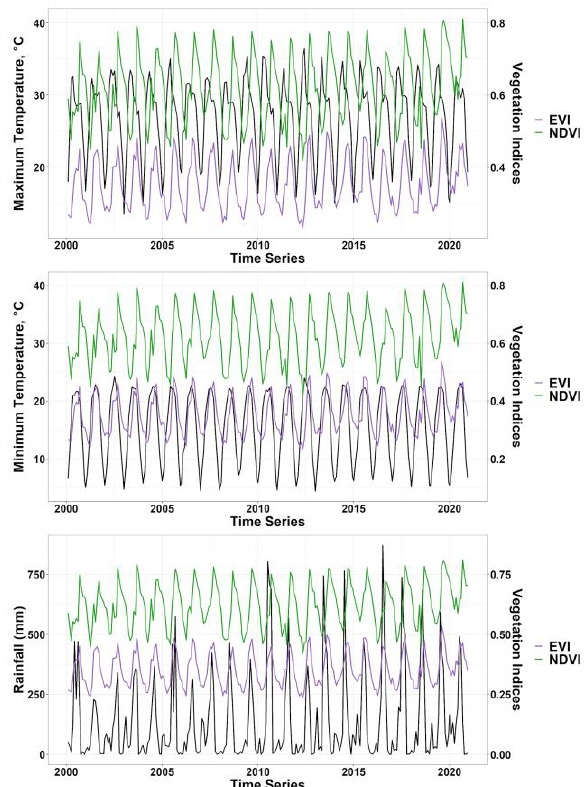
Figure 7 Temporal variation of vegetation indices and Climate Parameters in Nainital